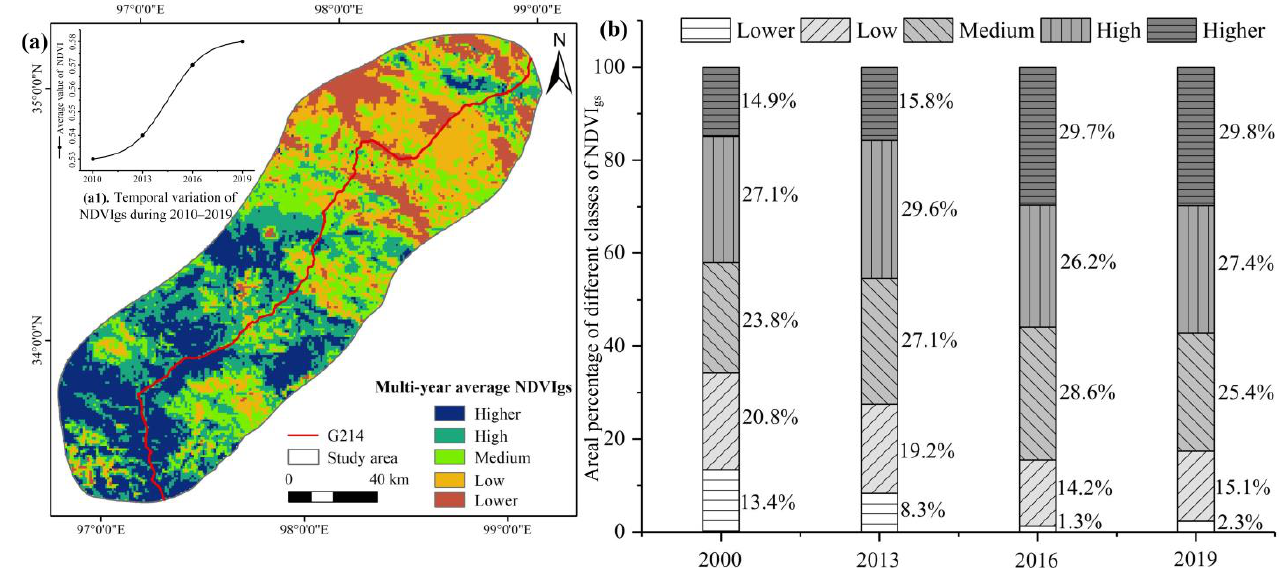
Figure 2. Distributive features of five classes of growth season Normalized Difference Vegetation Index (NDVI gs ) along the National Highway G214 from the Changshitoushan Mountain Pass to Qingshui’he Riverside at the northern and southern flanks of the Bayan Har Mountains, southern Qinghai, China. Notes: ( a ) Spatiotemporal variation of NDVI gs , averaged by NDVI gs during 2010 – 2019; ( b ) Areal percentage of different classes of NDVI gs in the study area in 2010, 2013, 2016, and 2019.